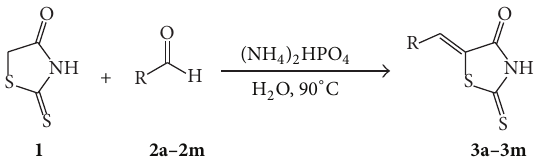
Scheme 1:Diammonium hydrogen phosphatecatalyzed synthesis of 5-arylidenerhodanines.